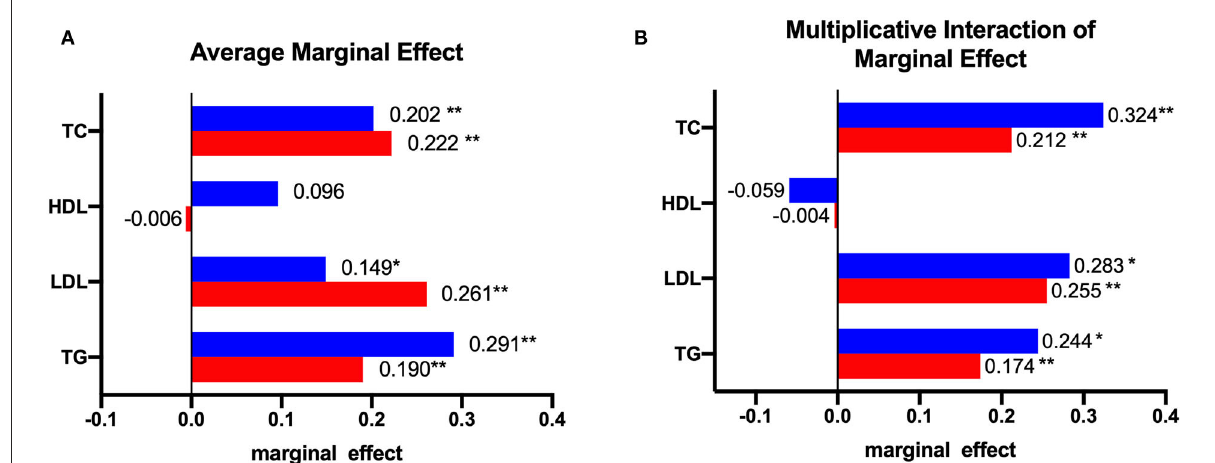
FIGURE1 The marginal effect: (A) shows the average marginal effect of alcohol consumption and meat consumption on blood lipids, the red bar represents the marginal effect of excessive consumption of meat, and the blue bar represents the marginal effect of alcohol consumption; (B) shows the marginal effect of alcohol consumption at a specific value (meat = 1, which means consumed more than 50g of meat per day), the red bar represents the marginal effect of excessive consumption of meat and no alcohol consumption on blood lipids, and the blue bar represents the effect of excessive consumption of meat and alcohol consumption on blood lipids. *represents P < 0.05; **represents P <